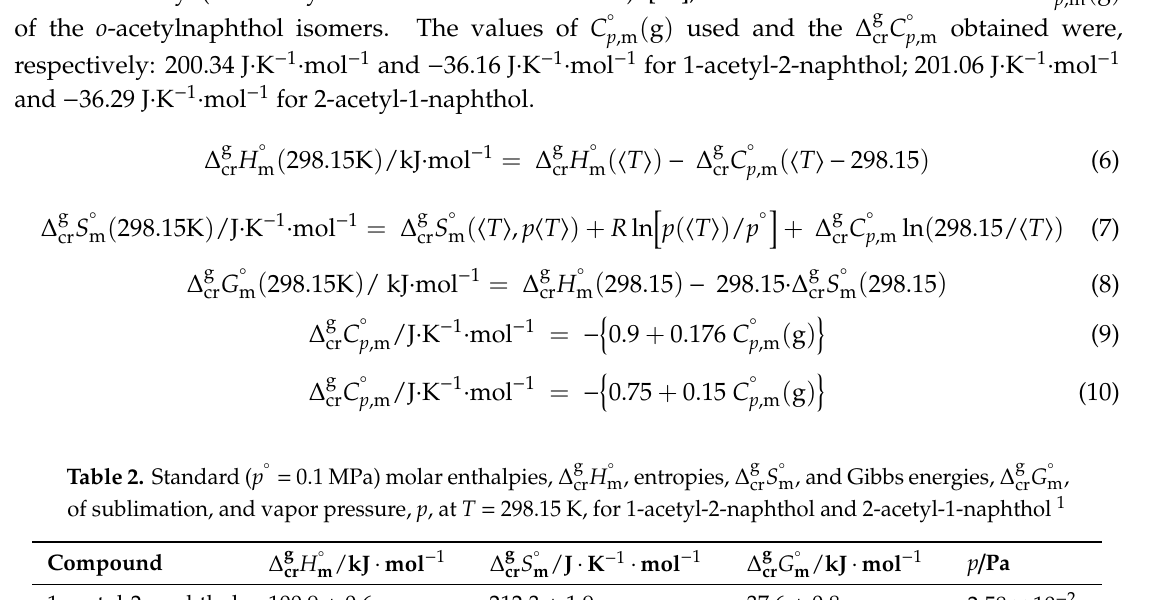
◦ ∆ g m , and Gibbs energies, cr S